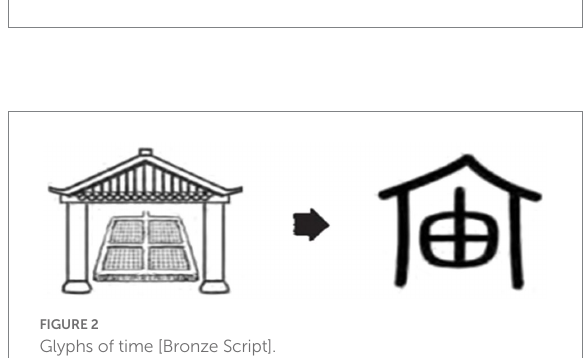
FIGURE 1 Glyphs of season [Small Seal Script].